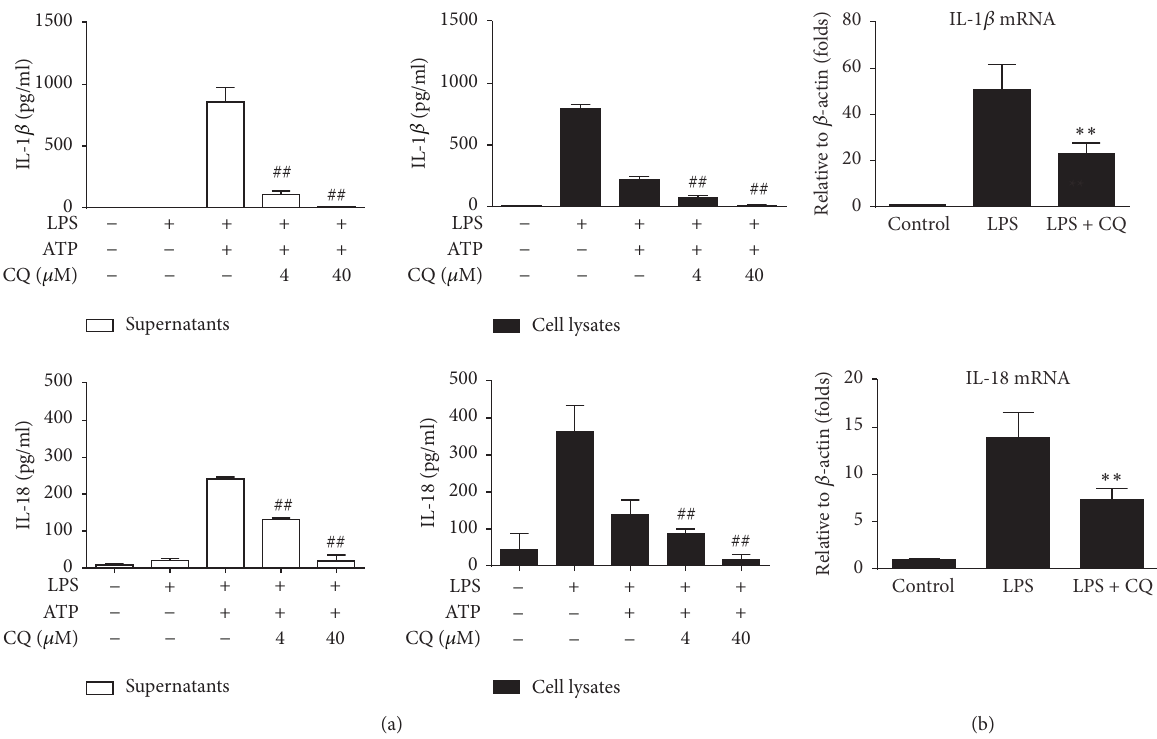
Figure 2: CQ inhibits transcription and maturation of IL-1 𝛽 and IL-18. (a) BMDMs were pretreated with CQ (4, 40 𝜇 M) for 1h, primed with LPS (100ng/ml) for 4 h, and stimulated with ATP (2 mM) for an additional 1h. Cell lysates and supernatants were prepared and IL-1 𝛽 level was detected by ELISA. ∗∗ 𝑃 < 0.01 versus LPS plus ATP group. (b) IL-1 𝛽 and IL-18 mRNA expressions were measured by qRT-PCR. BMDMs were pretreated with CQ (40 𝜇 M) for 1h and then primed with LPS (100ng/ml) for 2h. Data are shown as the means ± SEM ( 𝑛 = 3 ). ∗∗ 𝑃 < 0.01 versus LPS group; ## 𝑃 < 0.01 versus LPS plus ATP